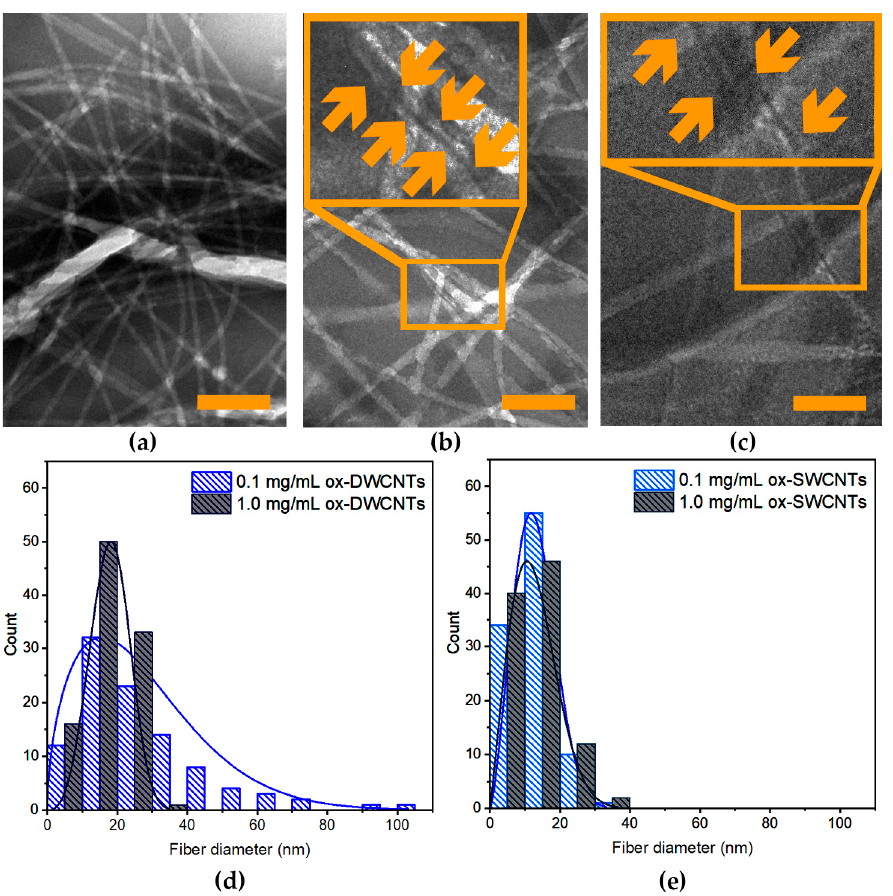
Figure 9. TEM analysis of composite hydrogels. ( a – c ) TEM micrographs of gels ( a ) without CNTs, and with 0.1 mg/mL ( b ) ox-DWCNTs or ( c ) ox-SWCNTs. Scale bars = 100 nm. ( d , e ) Peptide fibers’ diameter distributions for samples with ( d ) ox-DWCNTs and ( e ) ox-SWCNTs.